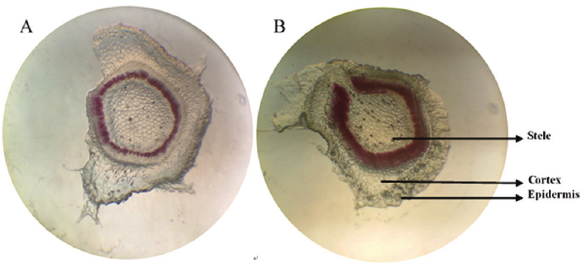
Figure5 -CrosssectionofmainstemsfromWT(A)andTT(B)seedlings, stained with phloroglucinol-HCl. The red part is the xylem of the main